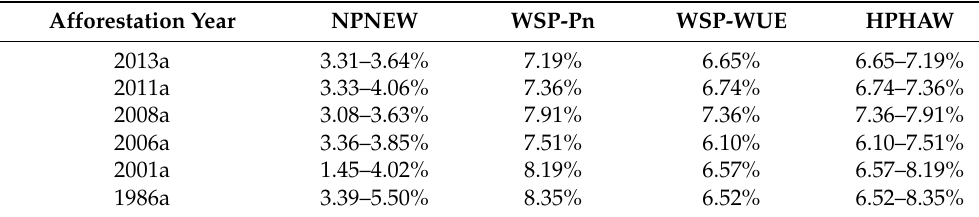
Figure 6. Regression fitting diagram of WUE and SWC. Table 5. Regression equation between photosynthetic parameters and SWC. Table 6. SWC threshold classification of photosynthetic parameters of C. intermedia